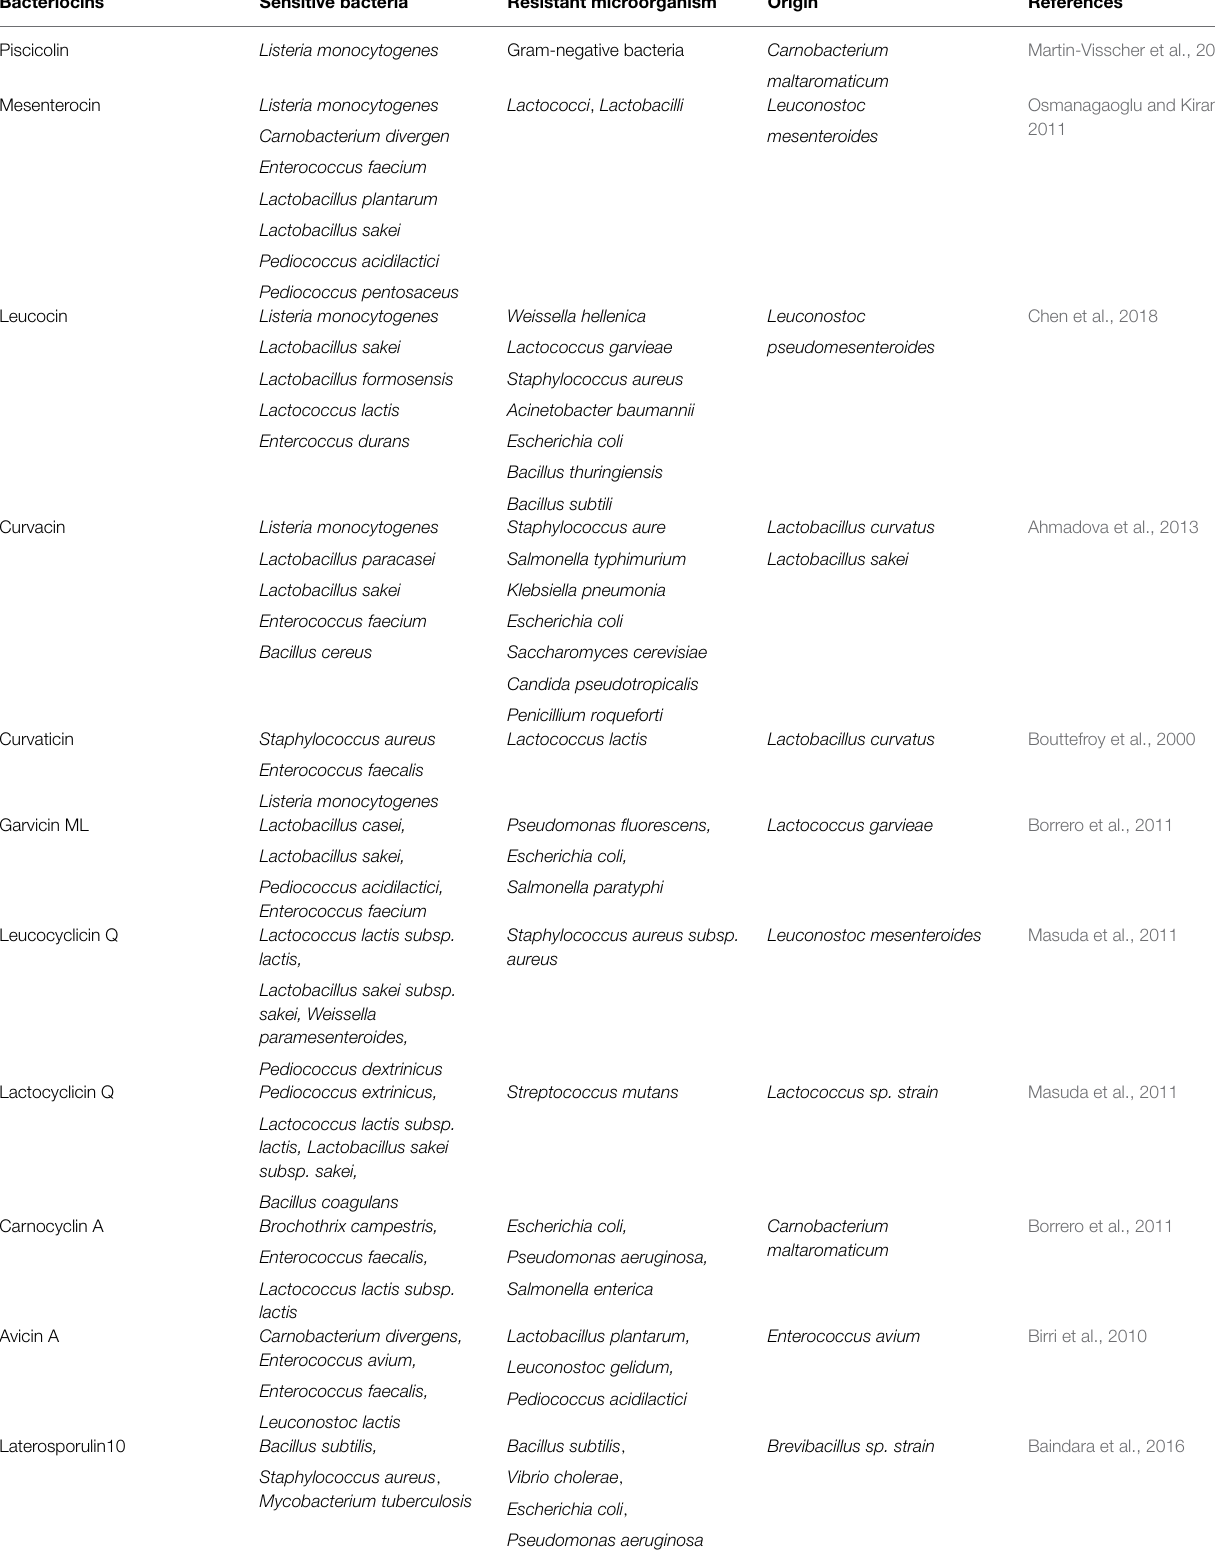
TABLE 1 | Selective antimicrobial activity of class II